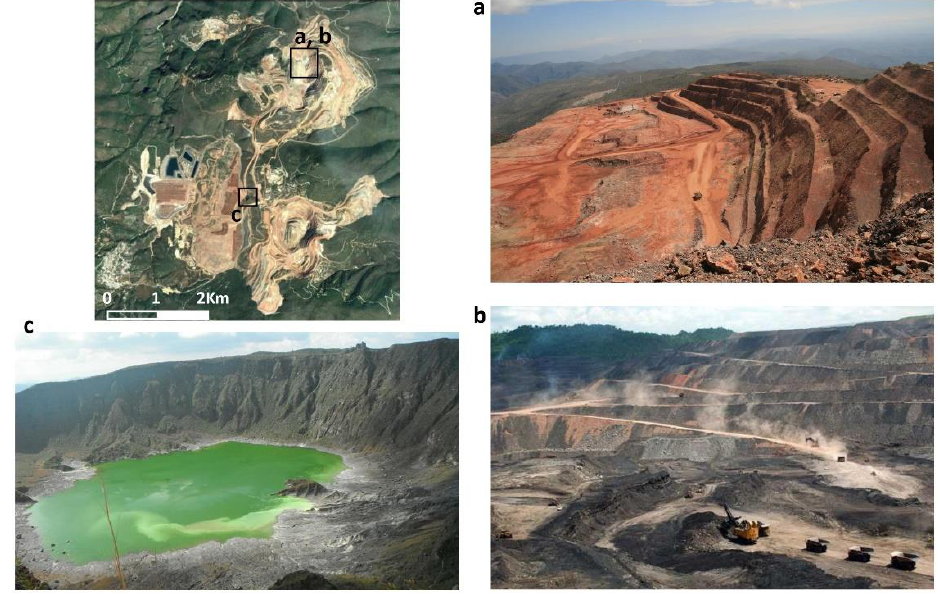
Figure 2. Mining in the study area. ( a , b ) Exploitation front at the El Tajo, Filos-Bermejal mine. ( c ) Waste reservoir, Jales dam. ( c ) Waste reservoir, Jales